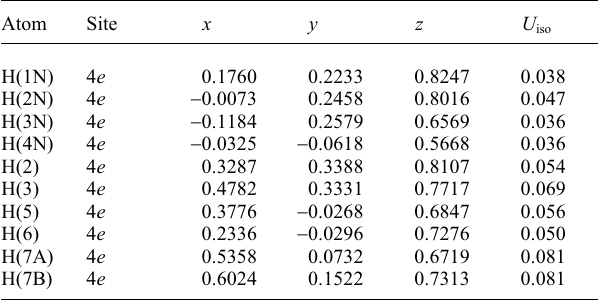
Table 2. Atomic coordinates and displacement parameters (in Å 2 )